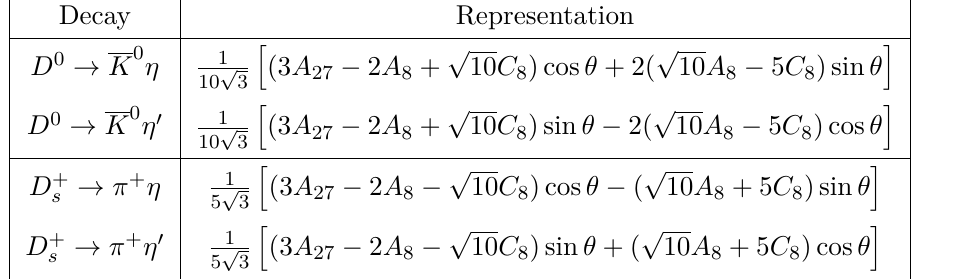
= A 8 and C (1) = C 8 in the SU(3) F 8 8